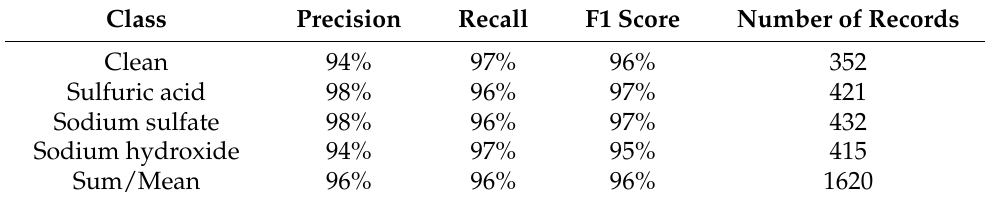
Table 5. Classification accuracy—pollutant detection and